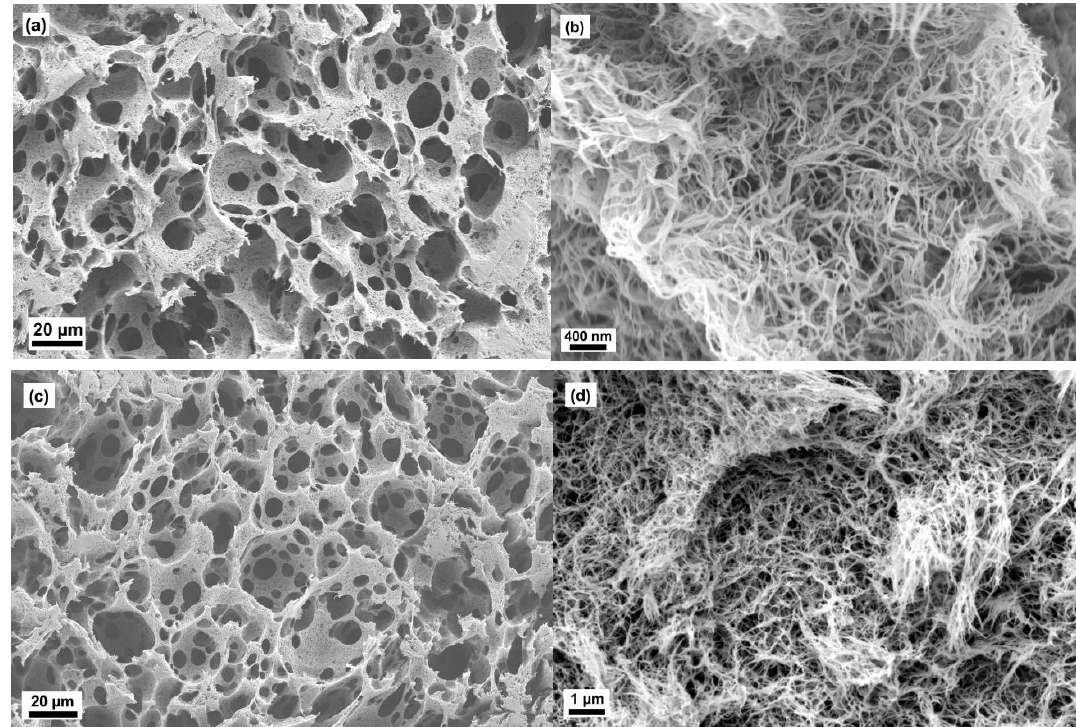
Figure 4. Scanning electron microscopic images of ACS-PN17 ( a,b ) and ACS-PS18 ( c,d ).